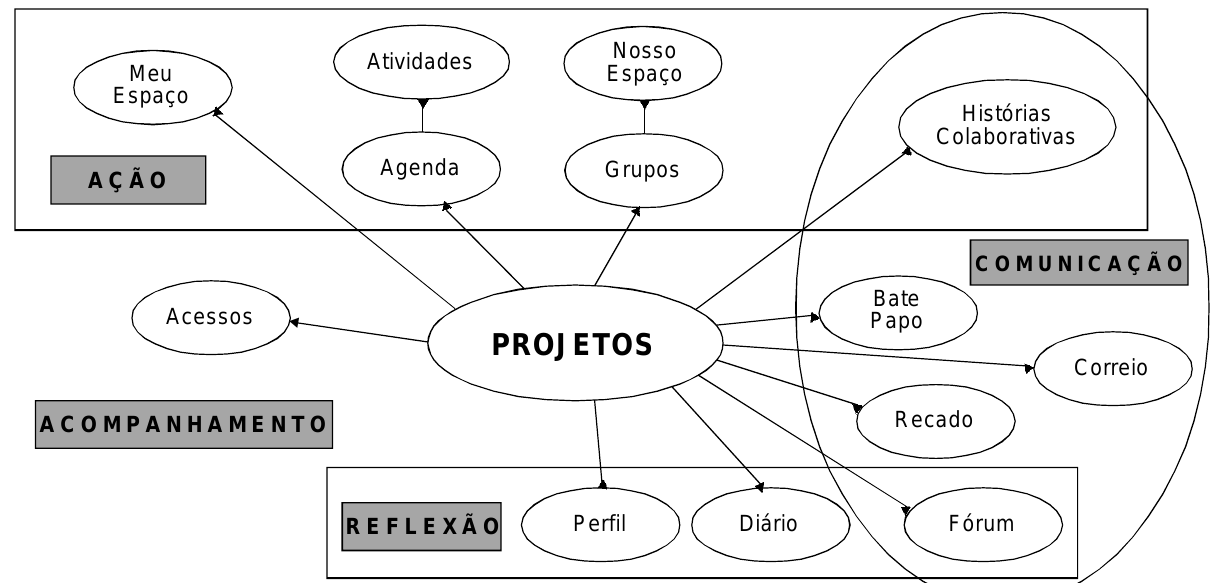
Figura 1. Representação da estrutura e recursos do